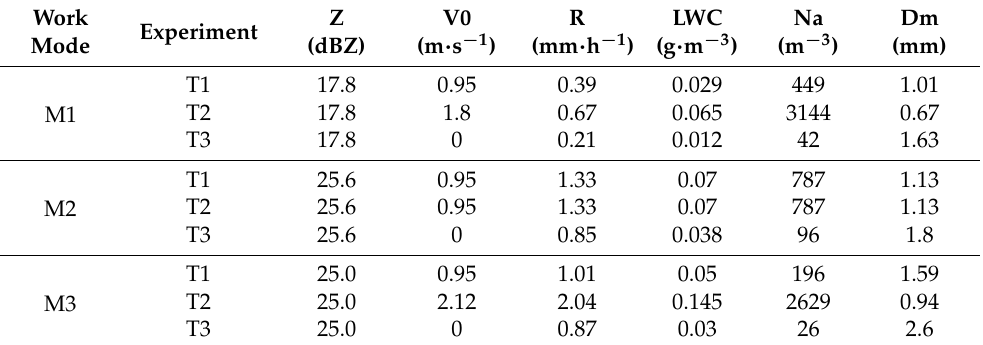
Table 3. Microphysical parameters retrieved in the three experiments. R—rain rate; LWC—liquid water content; Na—total number density; Dm—average